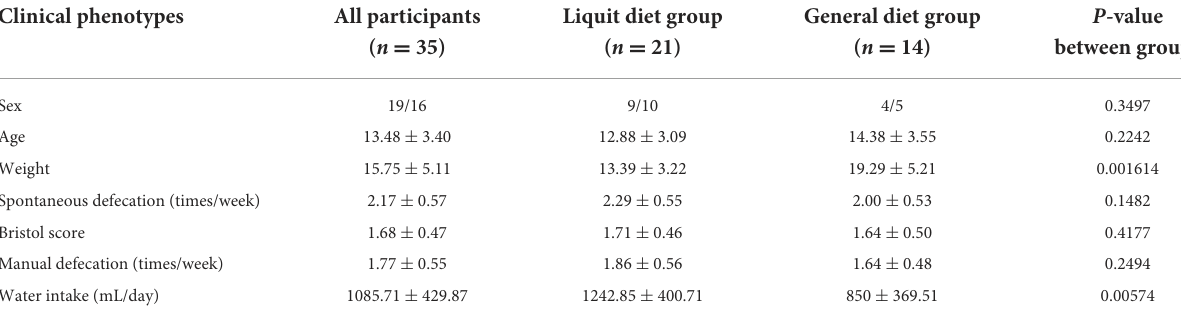
TABLE 1 Demographic and clinical characteristics of enrolled children at